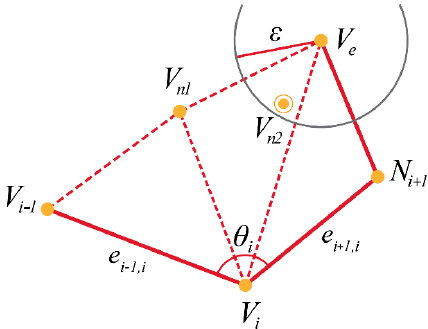
Figure 6. The threshold to check for overlaps and reduce mesh complexity where (cid:1874) (cid:3032) is an existing vertex within a radius of ∈ to the proposed vertex (cid:1874) (cid:3041)(cid:2870) . For the DietSensor application, larger values of ∈ were experimented with to simplify the mesh as much as possible to be computationally effective while retaining the general 3D geometry.